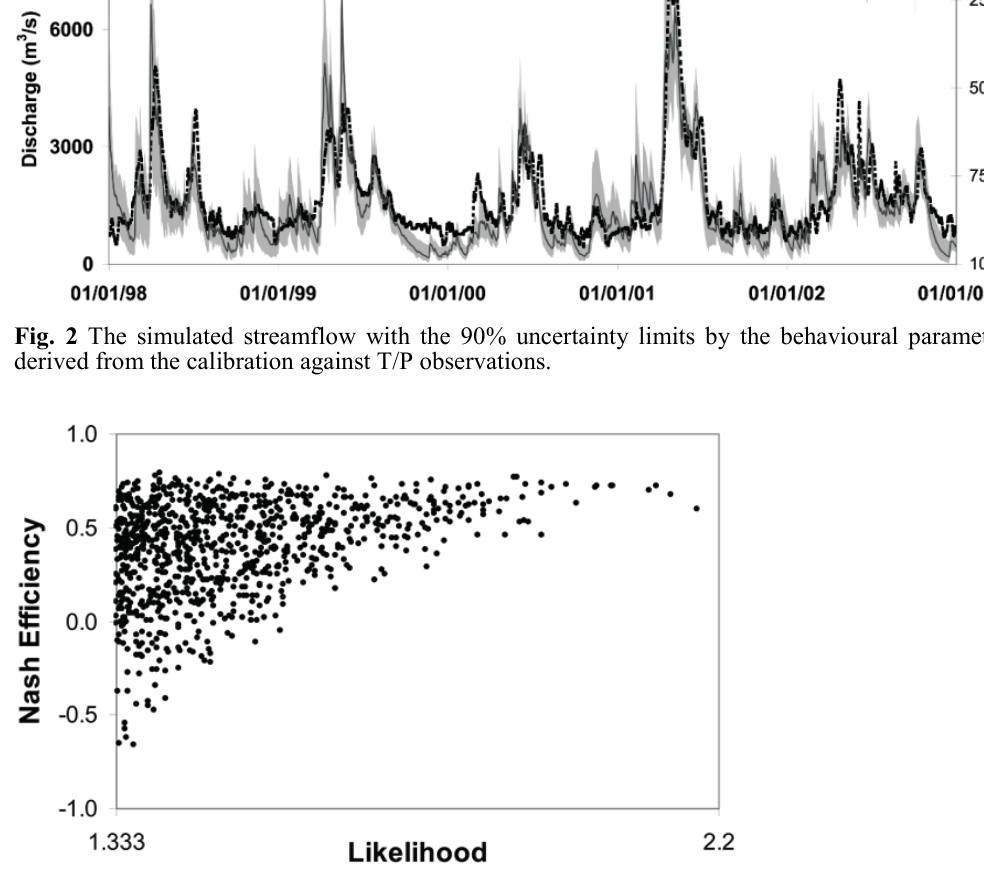
Fig. 3 Scatter plots of likelihoods versus Nash-Sutcliffe efficiencies for the behavioural parameter